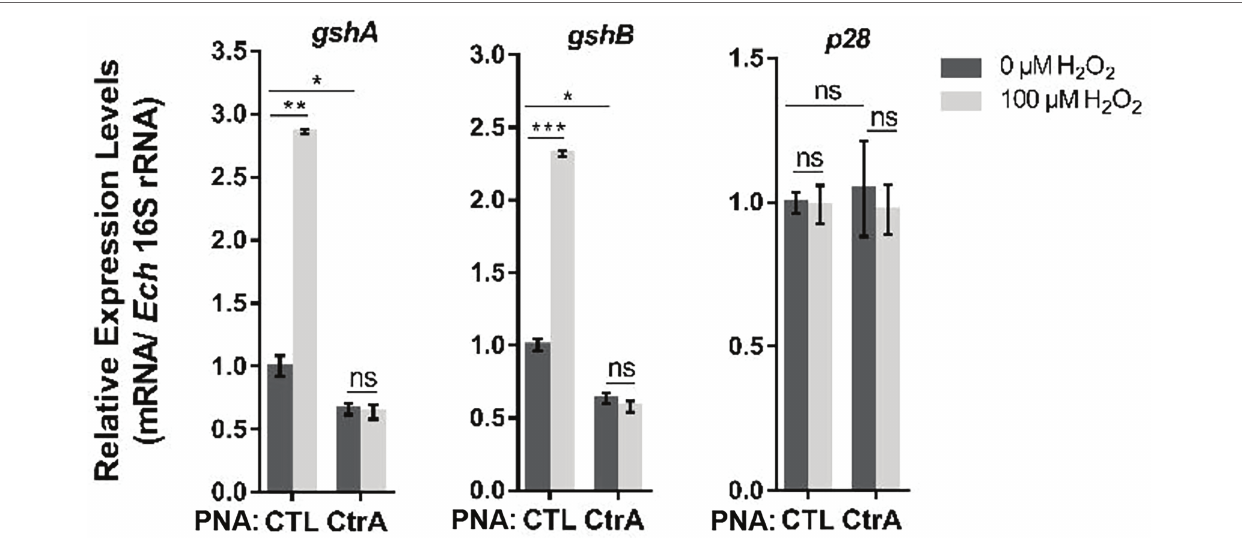
FIGURE 6 | Oxidative stress upregulates the expression of gshA and gshB via CtrA in E. chaffeensis . At 36 h p.i. THP-1 cells synchronously infected with CTL PNA- or CtrA PNA-transfected E. chaffeensis were treated with H 2 O 2 at a final concentration of 100 μ M or culture medium (CTL) at 37 ° C for 2 h. The expression levels of gshA , gshB , and p28 were determined with qRT-PCR and normalized against those of E. chaffeensis 16S rRNA. Relative values to the amount of CTL PNA-transfected E. chaffeensis without H 2 O 2 treatment are shown. Data indicate means ± standard deviations ( n = 3). The significant differences are represented by p -values determined with Student’s t -test (ns indicates p > 0.05, * p < 0.05, ** p < 0.01, and *** p <